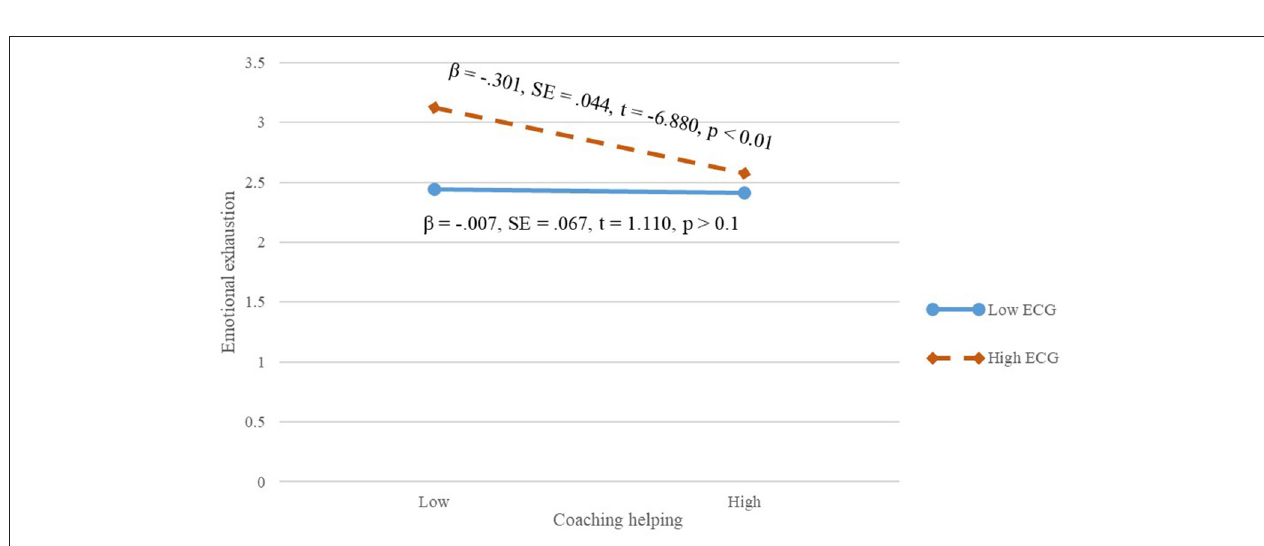
FIGURE 2 | Interactive effect of extrinsic career goals on the relationship between caring helping and employees’ emotional exhaustion.